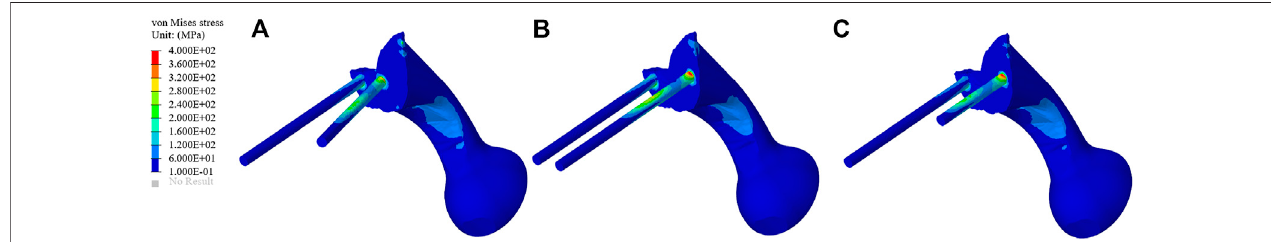
FIGURE4| Stressdistributionofthethreedifferent fi xationmethods. (A – C) Thestressdistributionofthebonemineraldensityscrew,longscrew,andshortscrew.